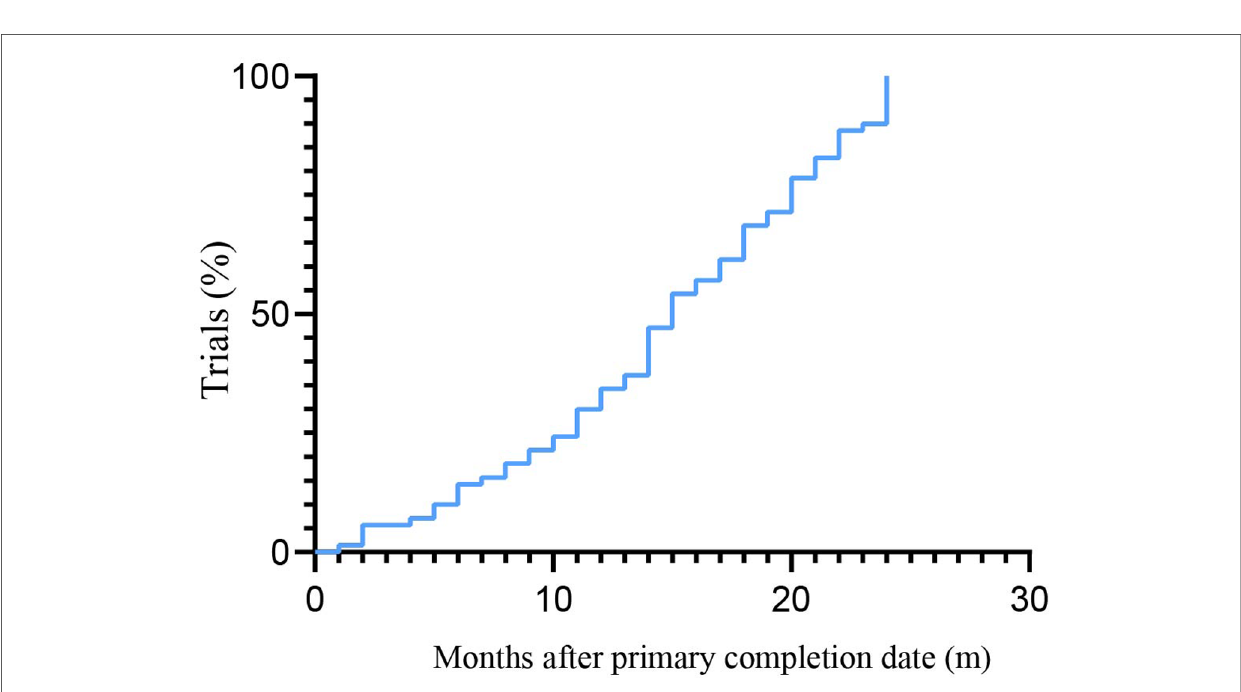
FIGURE 5 Cumulative publication percentage after the primary completion